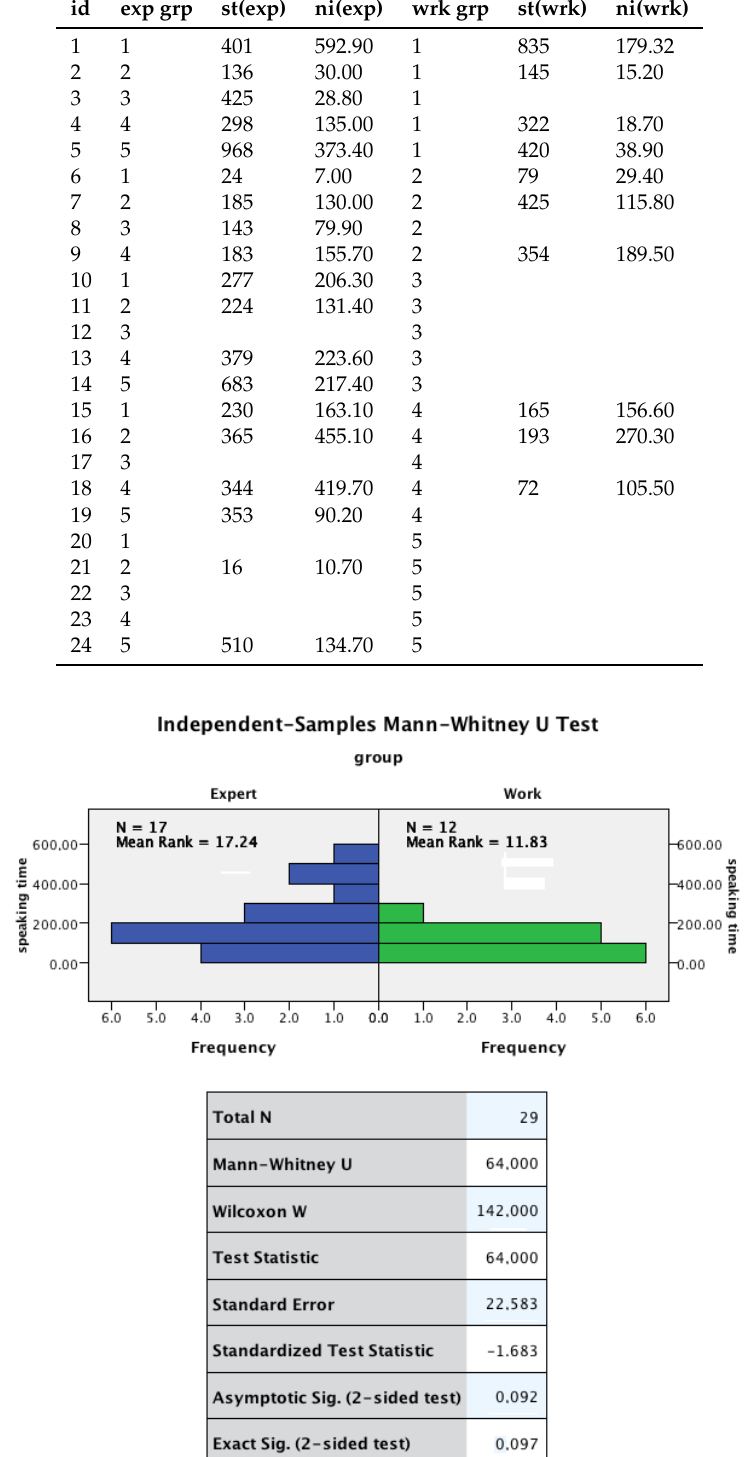
Figure 15. Independent-Samples Mann–Whitney U Test for student speaking time among expert and work